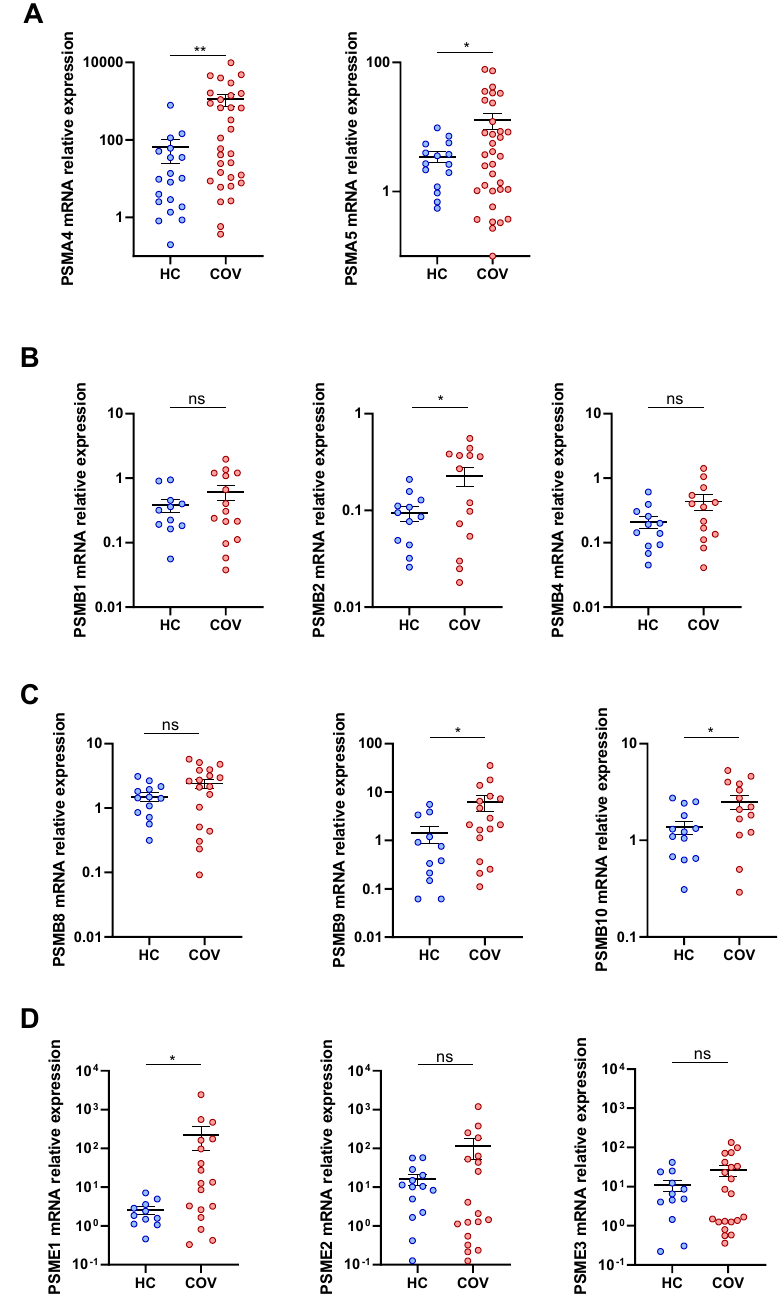
Figure 1. Upregulation of proteasome subunits in COVID-19 patients. mRNA expression in PBMCs from healthy controls (HC) compared to COVID-19 patients (COV) of ( A ) 20S proteasome alpha ring subunits: PSMA4 (HC n = 20; COV n = 32), PSMA5 (HC n = 15; COV n = 34); ( B ) 20S proteasome beta ring non-catalytic subunits: PSMB1 (HC n = 11; COV n = 15), PSMB2 (HC n = 12; COV n = 14), PSMB4 (HC n = 12; COV n = 13); ( C ) 20S immunoproteasome beta ring catalytic subunits: PSMB8 (HC n = 13; COV n = 18), PSMB9 (HC n = 12; COV n = 17), PSMB10 (HC n = 13; COV n = 14); and ( D ) 11S proteasome subunits: PSME1 (HC n = 11; COV n = 18), PSME2 (HC n = 14; COV n = 19), PSME3 (HC n = 12; COV n = 21). Mean differences were analysed using unpaired Student’s t -test analysis with Welch’s correction. Error bars: standard error of the mean. *: p < 0.05, **: p <